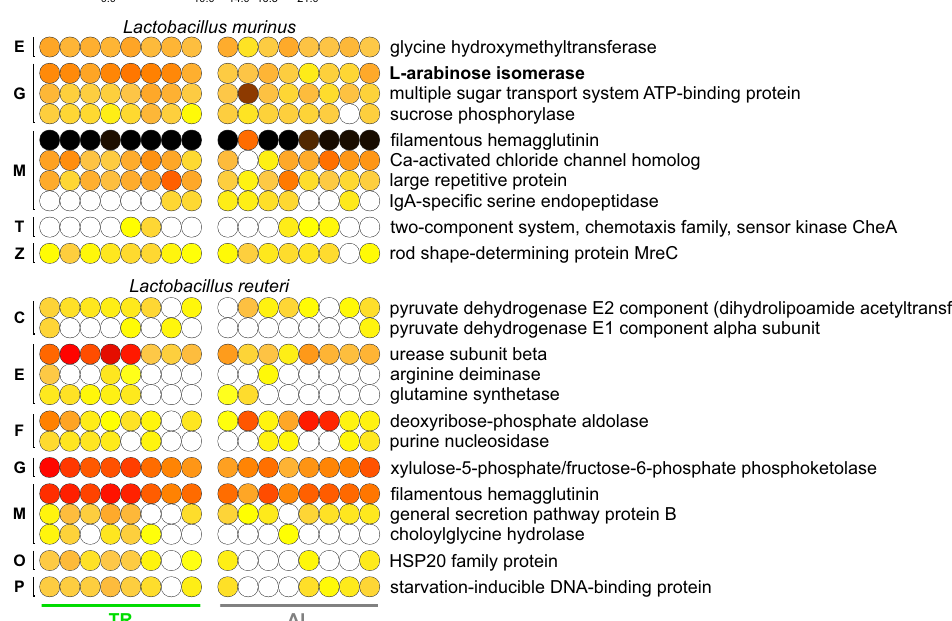
Fig. 5 Lactobacillus murinus / reuteri -speci fi c functions detected in fecal metaproteome samples of TR- and AL-fed rats. Functions in bold are differentially abundant between the two groups (FDR < 0.1; see Supplementary Fig. 9). Each dot indicates a different sample. The color gradient is based on the relative abundance of functions. Functions are ordered sequentially: (i) according to their COG category, indicated close to the left margin of the heatmap (C, Energy production and conversion; E, Amino acid transport and metabolism; F, Nucleotide transport and metabolism; G, Carbohydrate transport and metabolism; M, Cell wall/membrane/envelope biogenesis; O, Posttranslational modi fi cation, protein turnover, chaperones; P, Inorganic ion transport and metabolism; T, Signal transduction mechanisms; Z, Cytoskeleton); (ii) according to their average relative